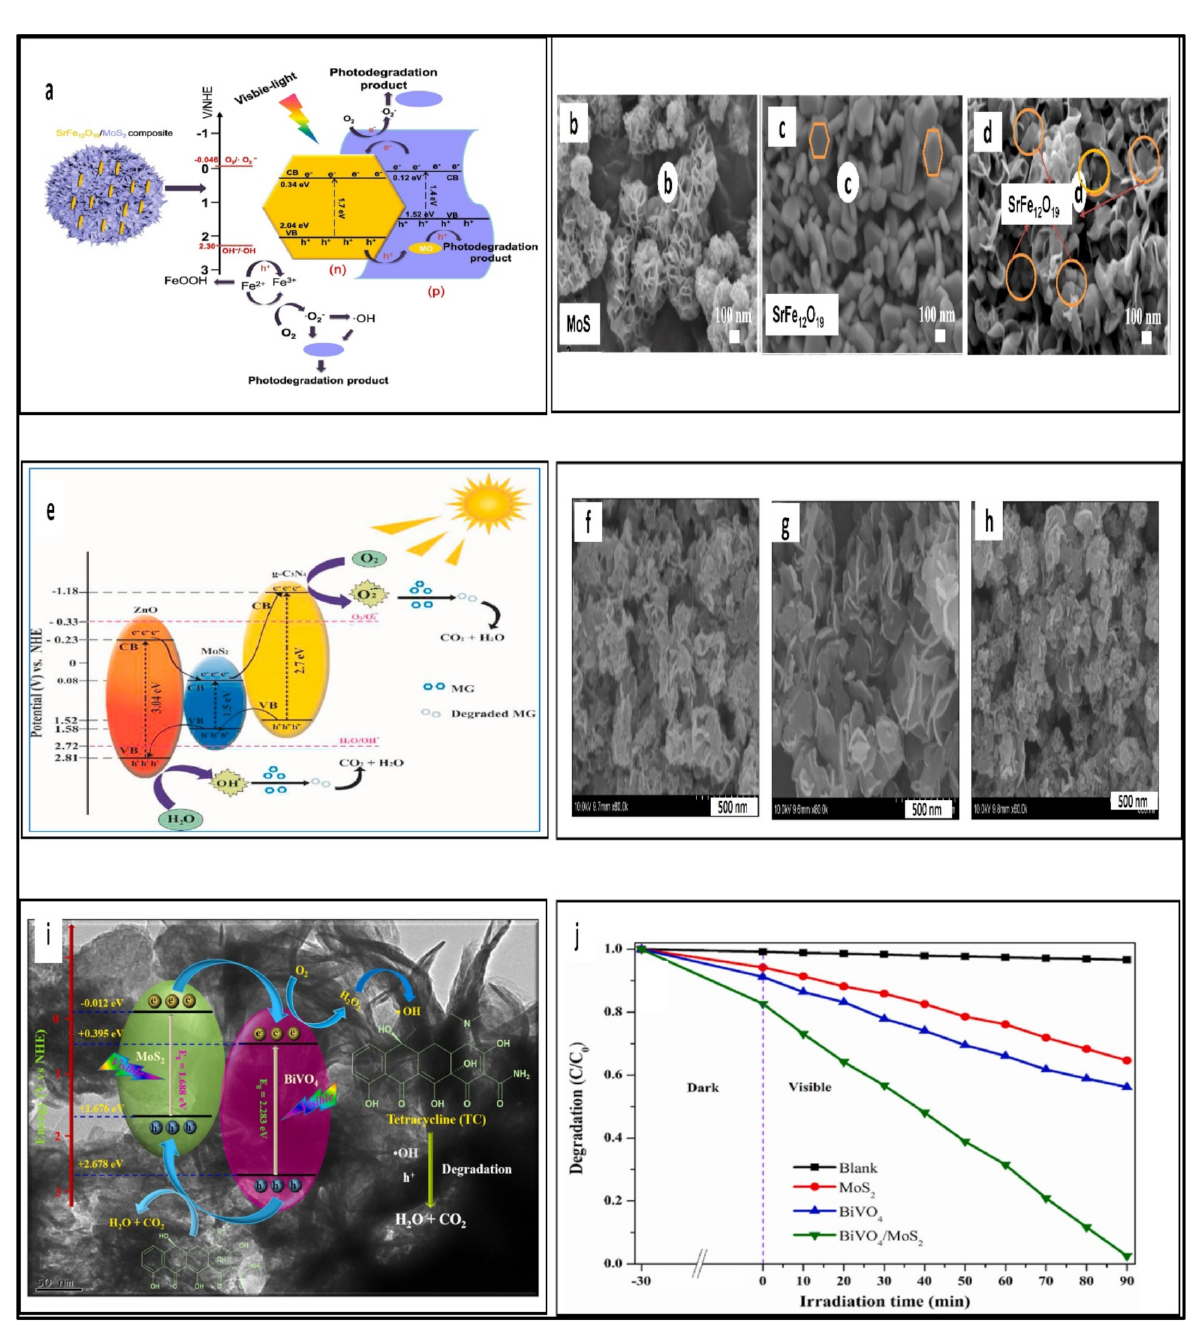
Figure 6. ( a ) The proposed photocatalytic degradation pathway of MB and MO, SEM im- ages ( b ) MoS 2 , ( c ) SrFe 12 O 19 , ( d ) SrFe 12 O 19 /MoS 2 (reprinted with permission, copyright Elsevier (2022)) [177]). ( e ) The proposed photocatalytic degradation pathway of MG (reprinted with permis- sion, copyright Elsevier (2022)) [178]). SEM images of ( f ) BiVO 4 nanosheets, ( g ) MoS 2 nanoflakes, and ( h ) BiVO 4 /MoS 2 nanocomposite; ( i ) the proposed photocatalytic degradation pathway of TC, ( j ) the photocatalytic removal curve of TC. (reprinted with permission, copyright Elsevier (2022))